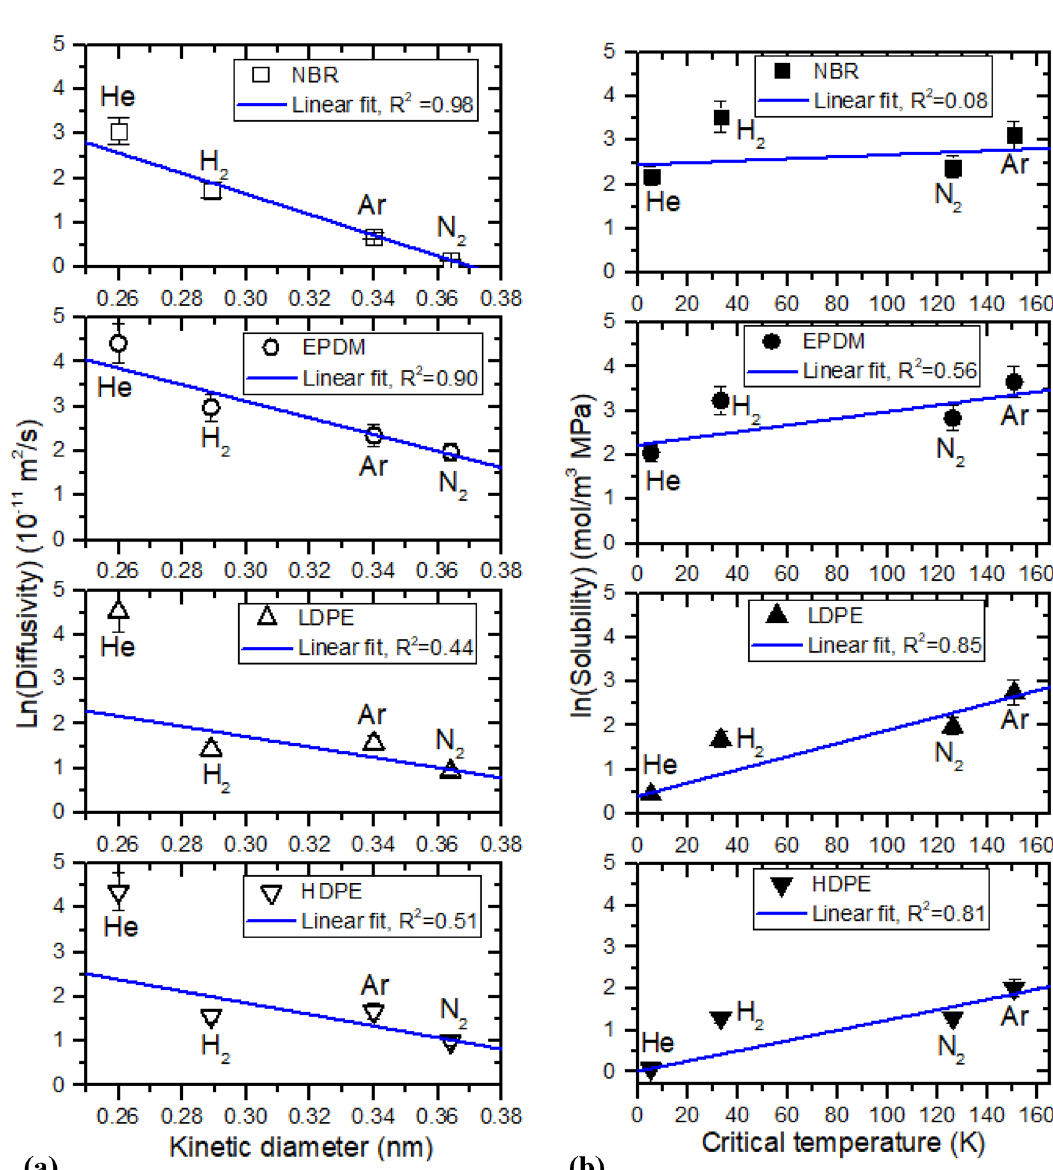
Figure 10. Linear correlation between ( a ) logarithmic diffusivity and kinetic diameter, ( b ) logarithmic solubility and critical temperature of gas molecules in NBR, EPDM, LDPE and HDPE